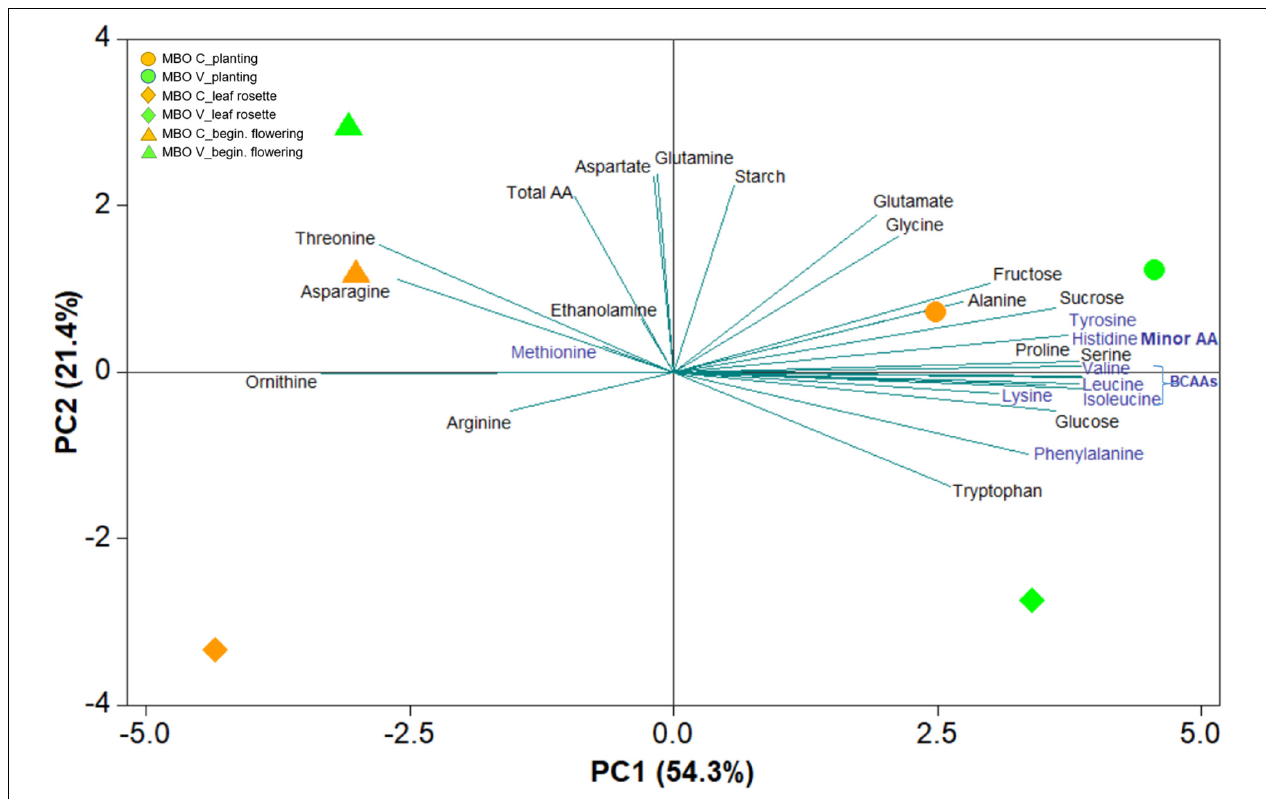
FIGURE 4 | Principal component loading plot and scores of principal component analysis (PCA) of sugars and free amino acids content in tuberous roots at three plant phenological stages (planting, leaf rosette, and beginning of flowering) of Ranunculus asiaticus L. hybrid MBO, obtained by two preparation procedures of tuberous roots, only rehydration (Control, C) and rehydration followed by vernalization